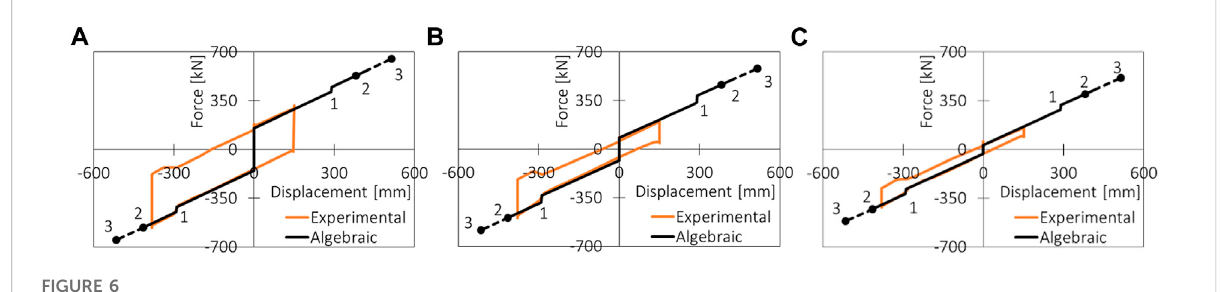
Frontiers in Built